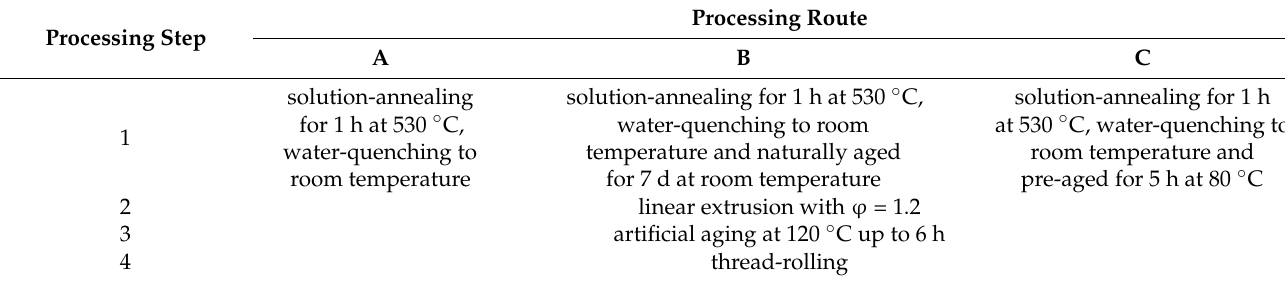
Table 2. Investigated processing routes of the used commercial 6056 aluminum